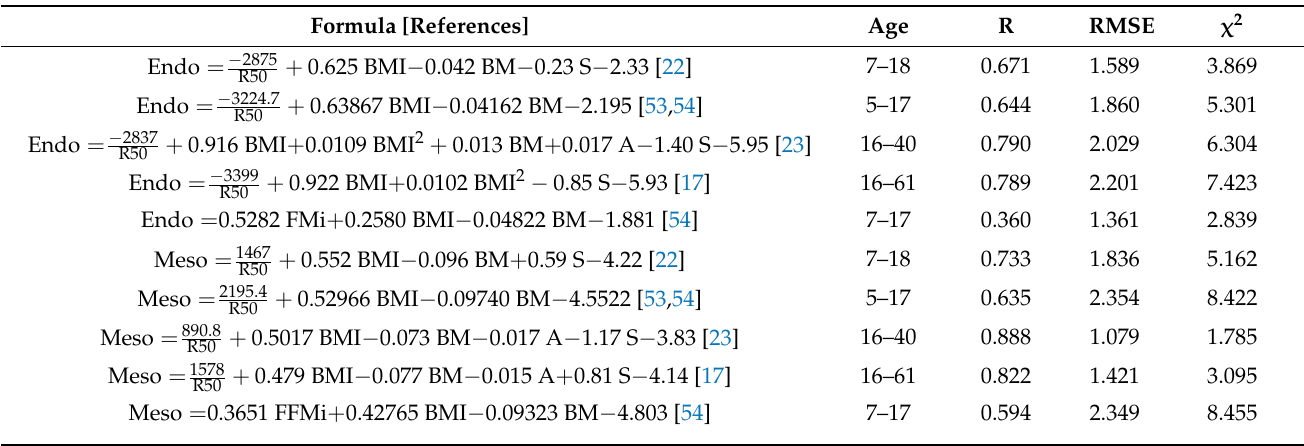
Table A1. Selected formulas, based on bioimpedance, for the evaluation of the endomorphy and mesomorphy rating of the Heath–Carter somatotype and results of statistical analyses on the modelling (S—sex, 1-M, 0-F; FMi = FM/H 2 —Fat Mass index, FFMi = FFM/H 2 —Free Fat Mass